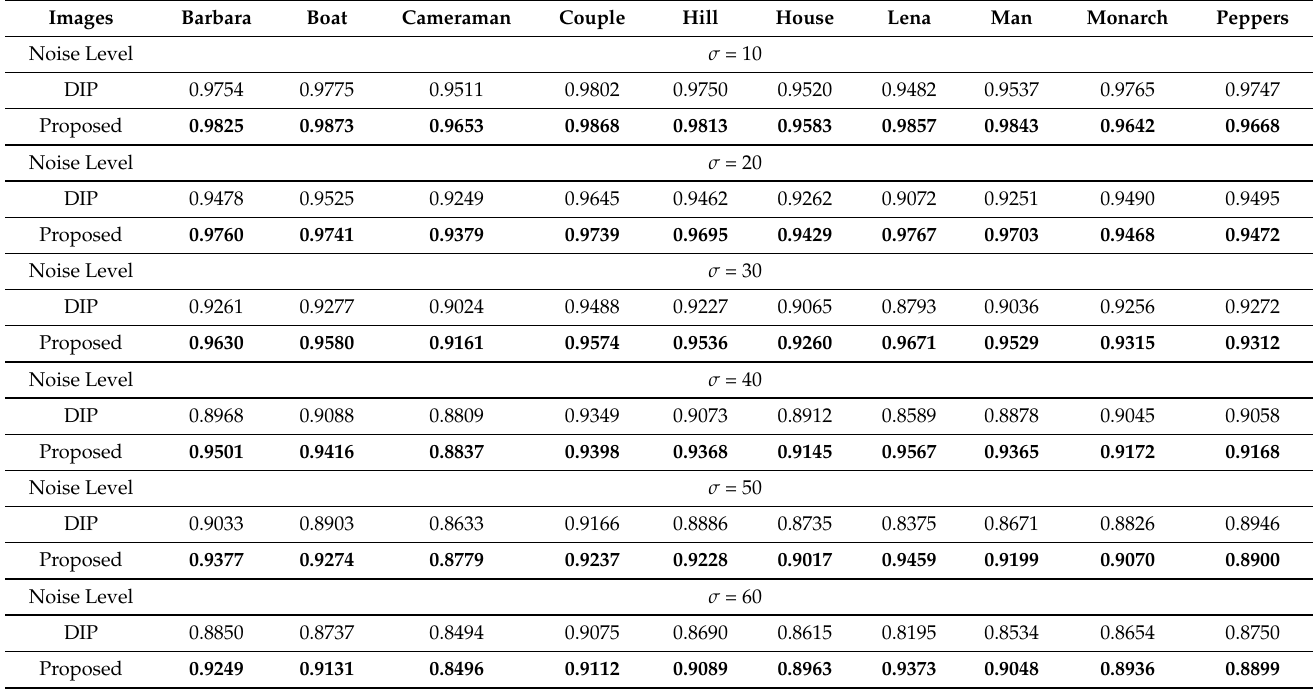
Table 4. FSIM results of two methods on 10 commonly used images with various noise